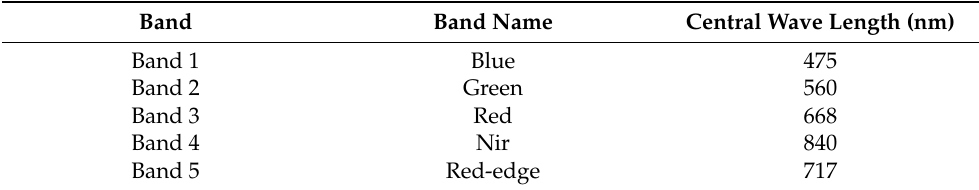
Table 1. Multispectral camera parameters.